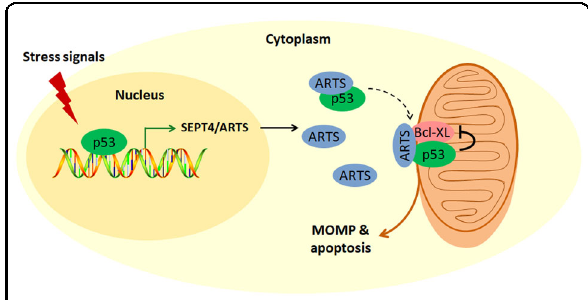
Fig. 7 A schematic for the p53-ARTS interplay in triggering mitochondrial apoptosis. Upon various stress conditions, p53 transcriptionally induces the expression of ARTS, which in turn interacts with and relocates p53 to the mitochondria. The interaction of p53 with Bcl-XL can be enhanced by ARTS, consequently leading to MOMP and